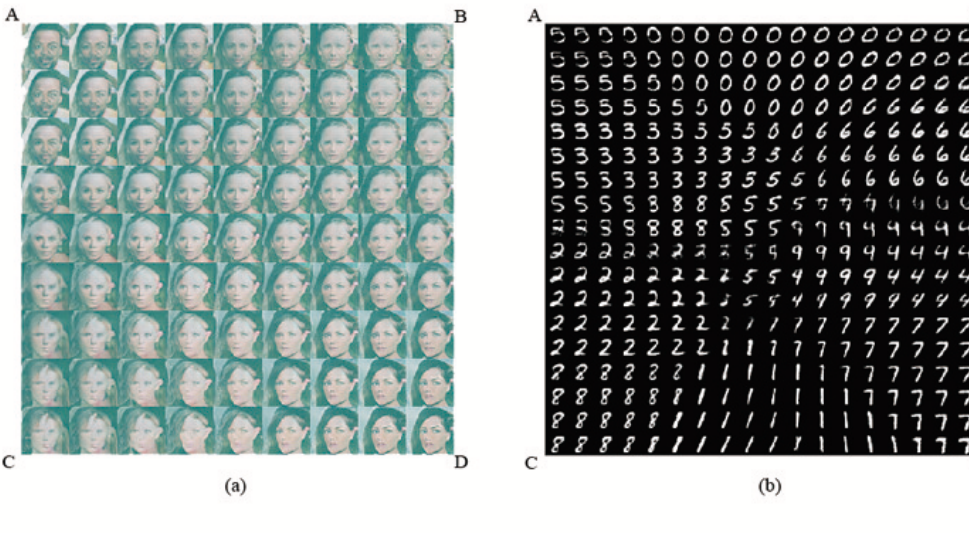
Figure 6. Latent space walk experiment on the generator learnt with VLGAN for ( a ) the celebA dataset and ( b ) MNIST